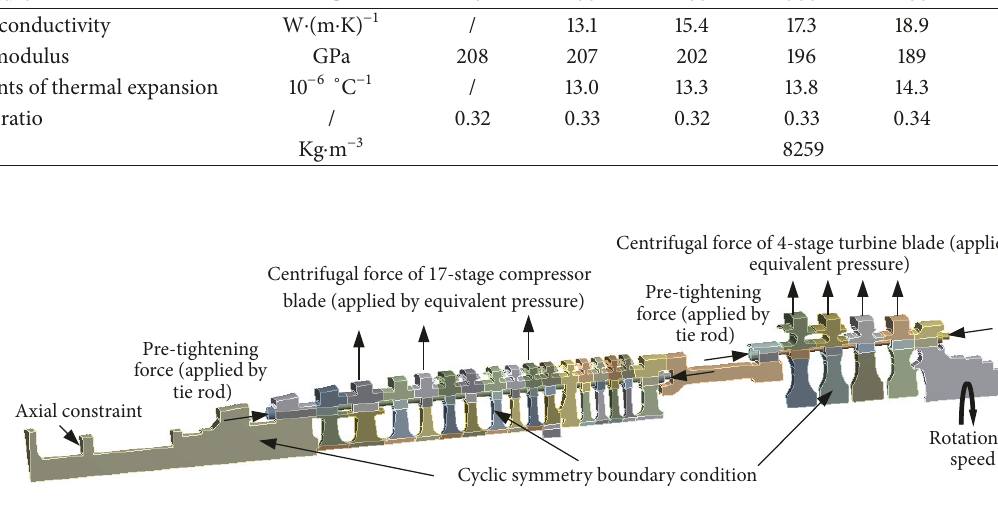
Figure 3: Schematic diagram of the boundary conditions and loads of the gas turbine